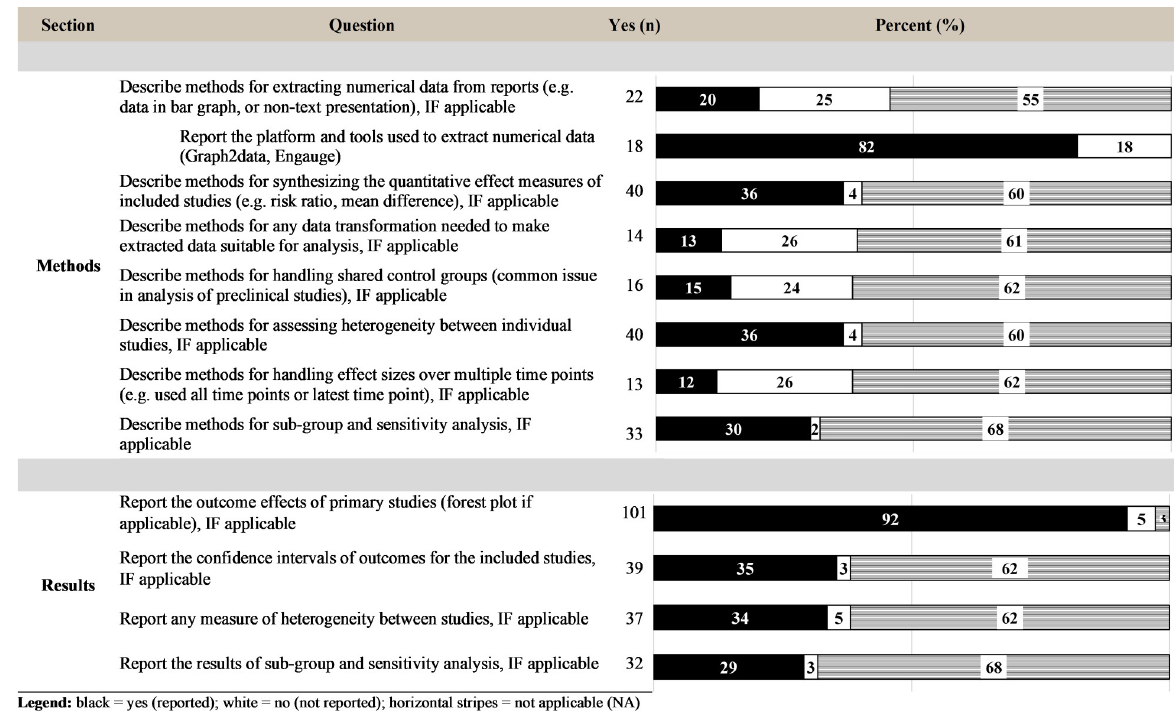
Fig 9. Level of reporting (count and percent) for the quantitative items within the methods and results